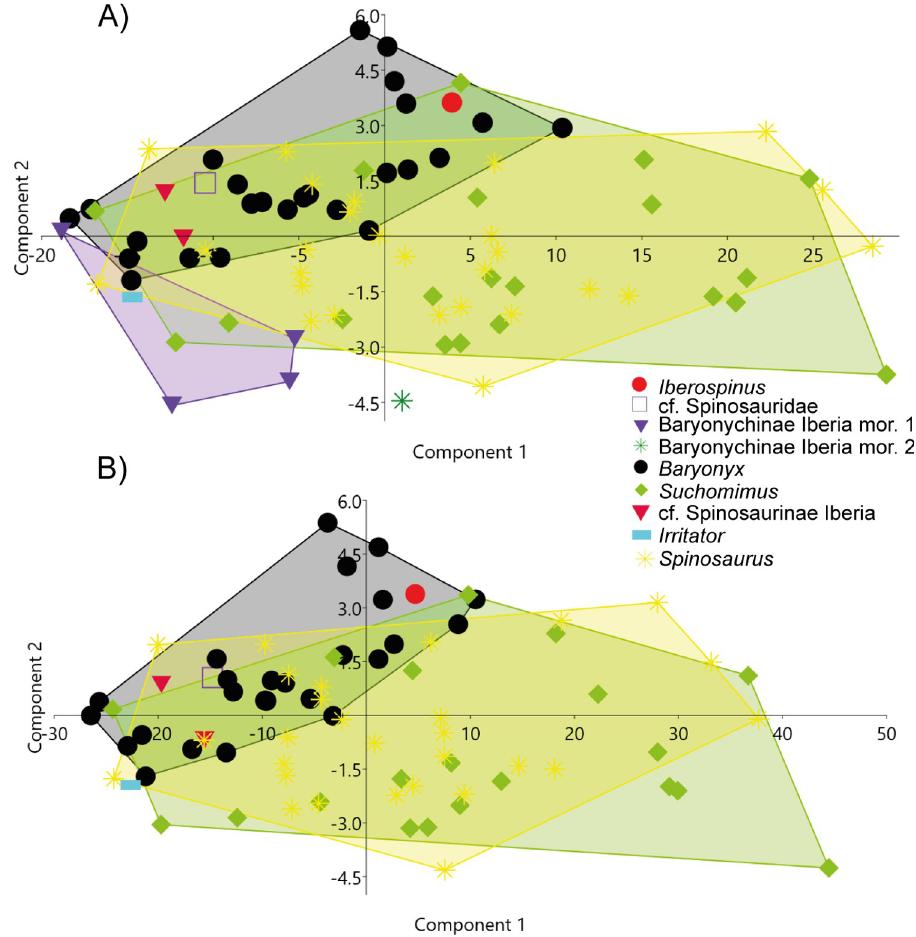
Fig 27. Principal component analyses (PCAs), including several measurements of the tooth of Iberospinus natarioi (ML1190-3) with a sample of other Spinosauridae teeth. A , First PCA, including Iberian Baryonychinae specimens; B , Second PCA, including apical length (AL) measurements and removal of specimens that were missing them in the bibliography. Red dot , ML1190-3; Black dot , Baryonyx teeth; Blue square , possible basal Spinosauridae from Niger; Crimson inverse triangle , possible Iberian Spinosaurinae; Green diamonds , Suchomimus teeth; Violet inverse triangles , Iberian Baryonychinae morphotype 1; Green star , Iberian Baryonychinae morphotype 2; Blue dash , Irritator tooth; Yellow stars , Spinosaurus